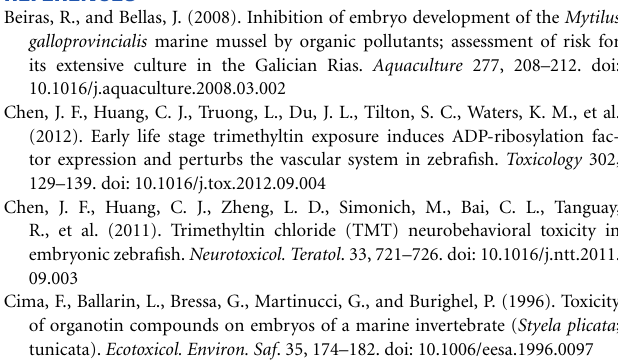
(2004) with permission. cg, capsule gland; ov, ovary; p, penis; vd, vas deferens; e, eye; f, fin; bt, bent tail; te, turbid lens of eyes; nf, narrow fin; pe, protruding